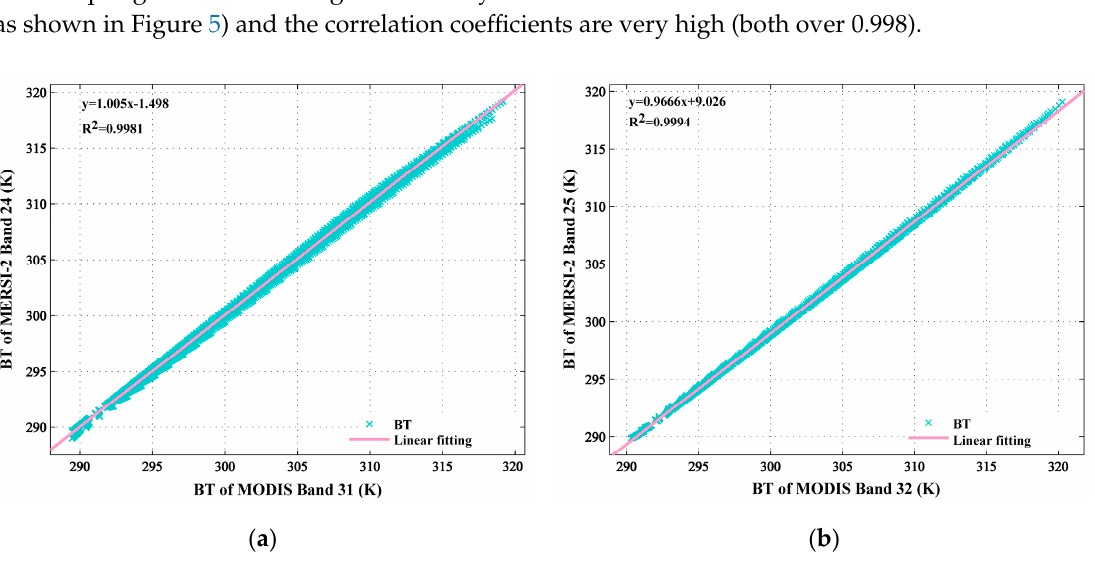
Figure 5. BT (simulated value) statistical regression for converting the BT of MODIS Band 31 to the BT of MERSI-2 Band 24 ( a ) and the BT of MODIS Band 32 to the BT of MERSI-2 Band 24 ( b ).